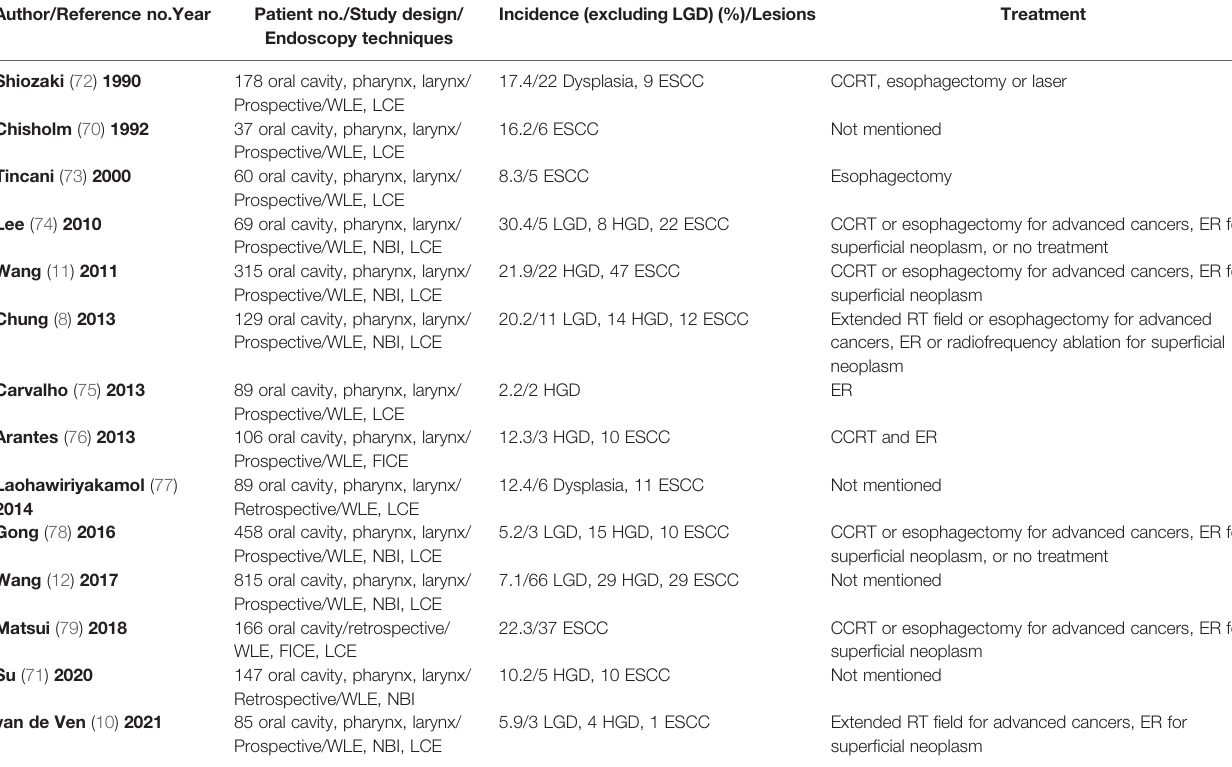
TABLE 2 | Image-enhanced endoscopic screening of synchronous or metachronous esophageal neoplasm in HN cancer patients. Author/Reference